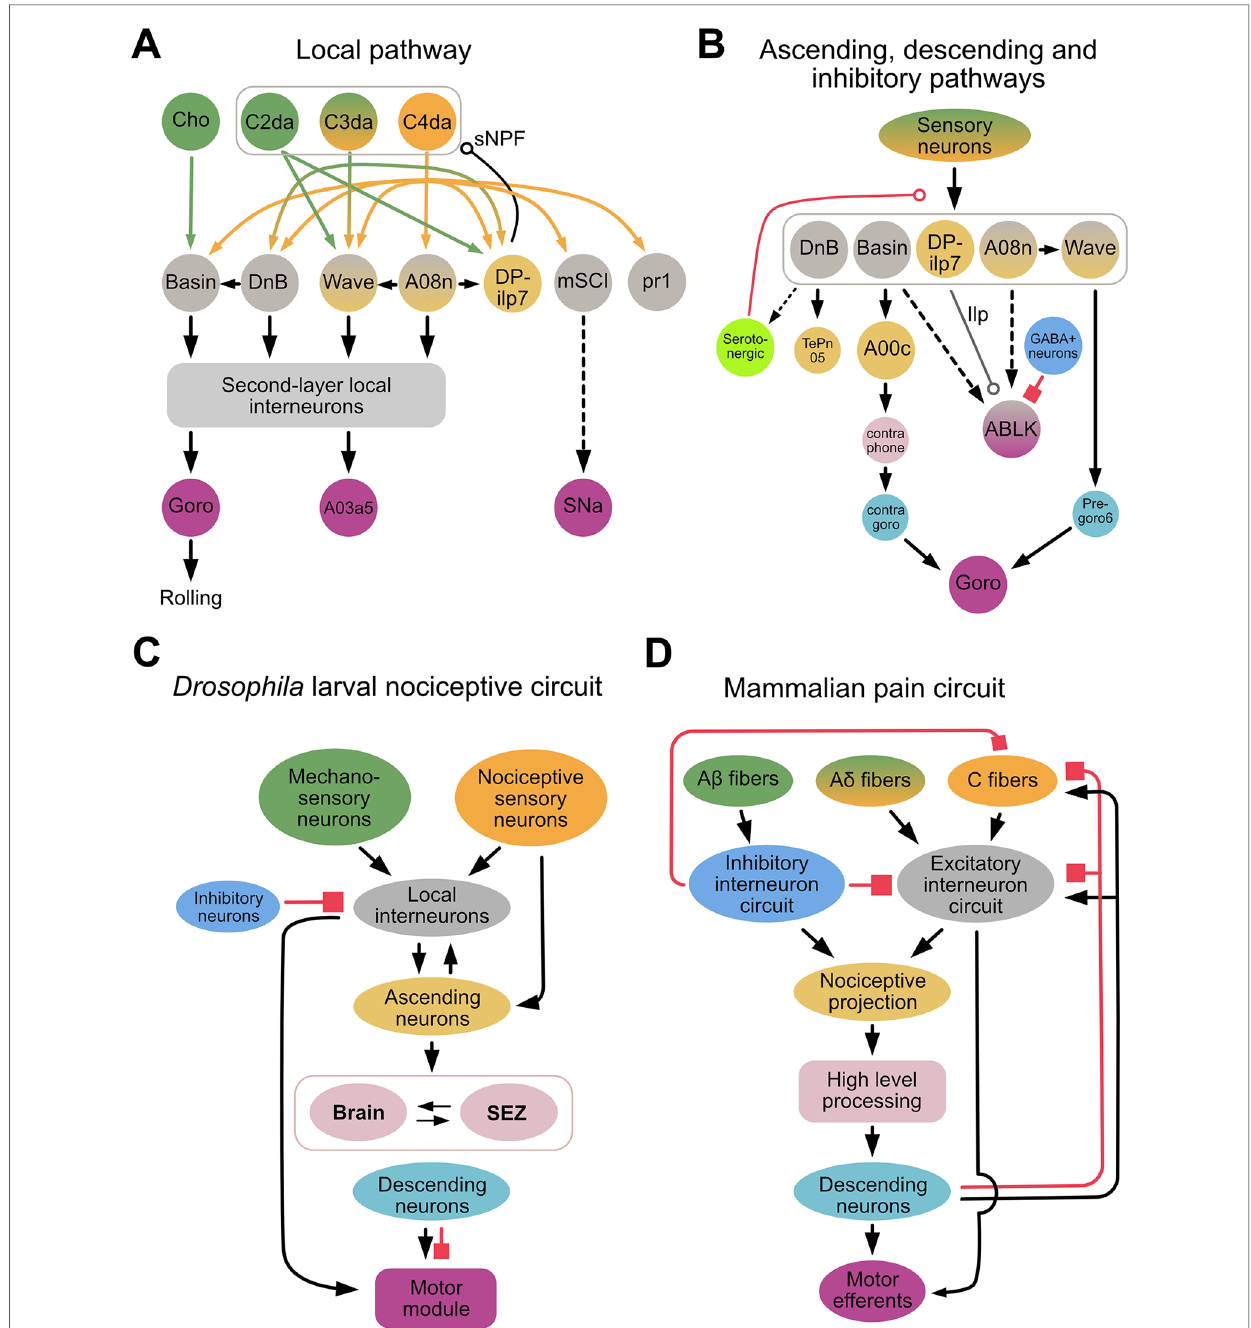
FIGURE 2 Drosophila larval nociceptive circuit. ( A ) A detailed diagram of local excitatory pathways in the Drosophila larval nociceptive circuit. Mechanosensory and nociceptive neurons are shown in green and orange, respectively. Local interneurons are shown in gray, and second-layer local interneurons (e.g., A23g, A05q, A02g, T05u, Swallowtail, and A09o) are represented collectively by a gray bracket. The command-like neuron Goro, the pre-motor neuron A03a5, and the motor neuron SNa are shown in purple; these neurons comprise a motor module. ( B ) A diagram showing key neurons comprising the ascending, descending, and inhibitory/modulatory pathways of the Drosophila larval nocifensive rolling circuit. Ascending neurons are shown in yellow; neurons in the brain and subesophageal zone (SEZ) in pink; descending neurons in cyan; and inhibitory neurons in blue. In both ( A,B ), bi-colored neurons (e.g., Wave, A08n) send projections locally within the ventral nerve cord (VNC) as well as ascending projections to the brain or SEZ. (Whether ABLK neurons are local interneurons or part of the motor module remains unclear.) Solid and dotted lines indicate direct and indirect connections, respectively. A line terminating in an arrowhead, open circle, or fi lled square denotes a connection with an excitatory, modulatory, or inhibitory in fl uence, respectively, on the target neuron. In ( B ), smaller neurons represent those identi fi ed morphologically from EM reconstruction data but whose biological functions remain unclear. Note that DP-ilp7, which is activated by short-wavelength lights, releases insulin like-peptide (Ilp). The modulatory in fl uence of serotonergic neurons (light green) has thus far only been reported in experience-dependent plasticity during development. ( C,D ). Simpli fi ed diagrams of the Drosophila larval nociceptive circuit ( C ) and mammalian pain circuit ( D ). In both circuits, multi-modal sensory inputs (green and orange) activate excitatory networks, including integrating layers (gray), ascending projections (yellow), higher-order processing centers (pink), descending pathways (cyan), and motor outputs (purple). In both circuits, several inhibitory neurons (blue) project to various